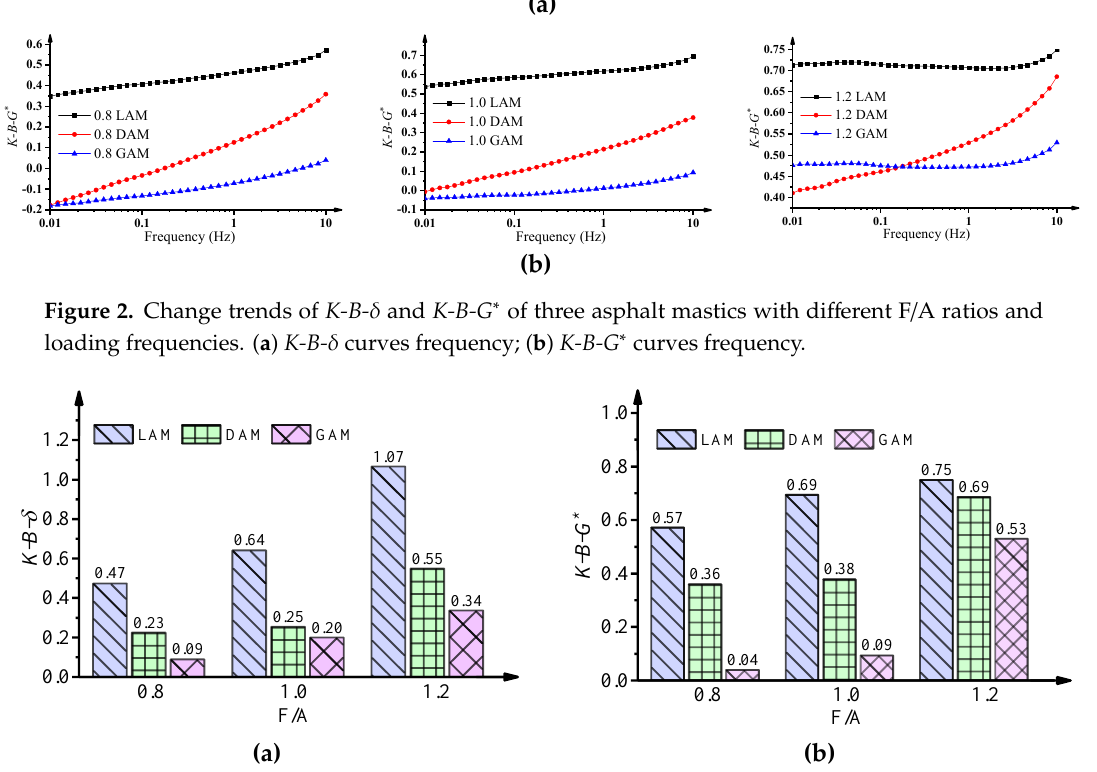
Figure 3. Maximum values of K-B- δ and K-B-G ∗ of three asphalt mastics with di ff erent F / A ratios. ( a ) K-B- δ curves F / A; ( b ) K-B-G ∗ curves F / A.